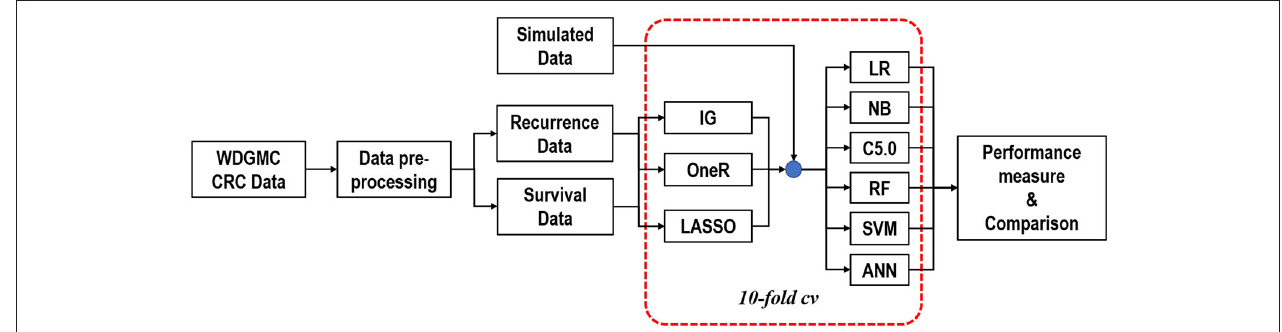
FIGURE 1 | Graphical representation of the modelling approach to predicting CRC recurrence and